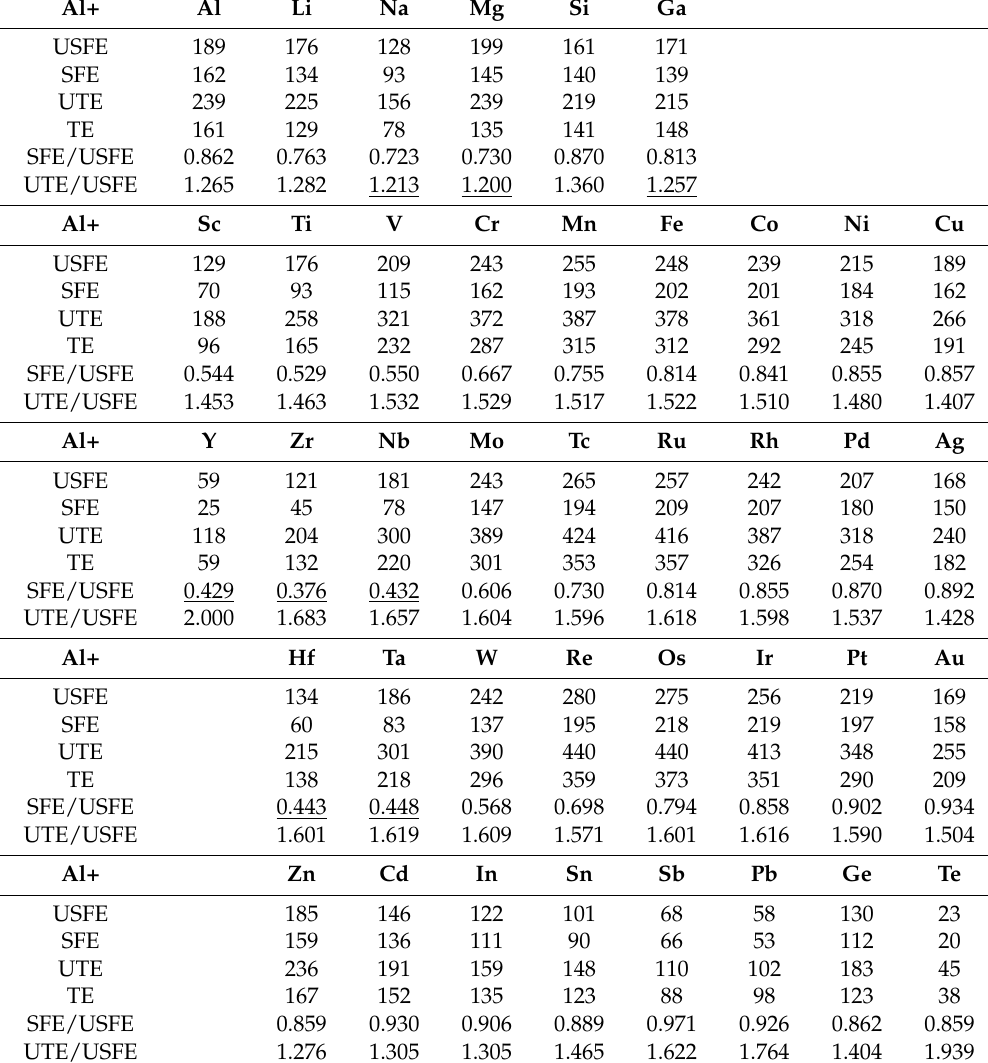
Table 1. Calculated values of unstable stacking fault energy (USFE), stacking fault energy (SFE) and unstable twining energy (UTE) for Al and their alloys. Results for Al alloys with Mg, Ga, Zn, Si and Cu are from our previous calculations [12]. The most reduced SFE/USFE and UTE/USFE values are underlined. All energies are in mJ/m 2